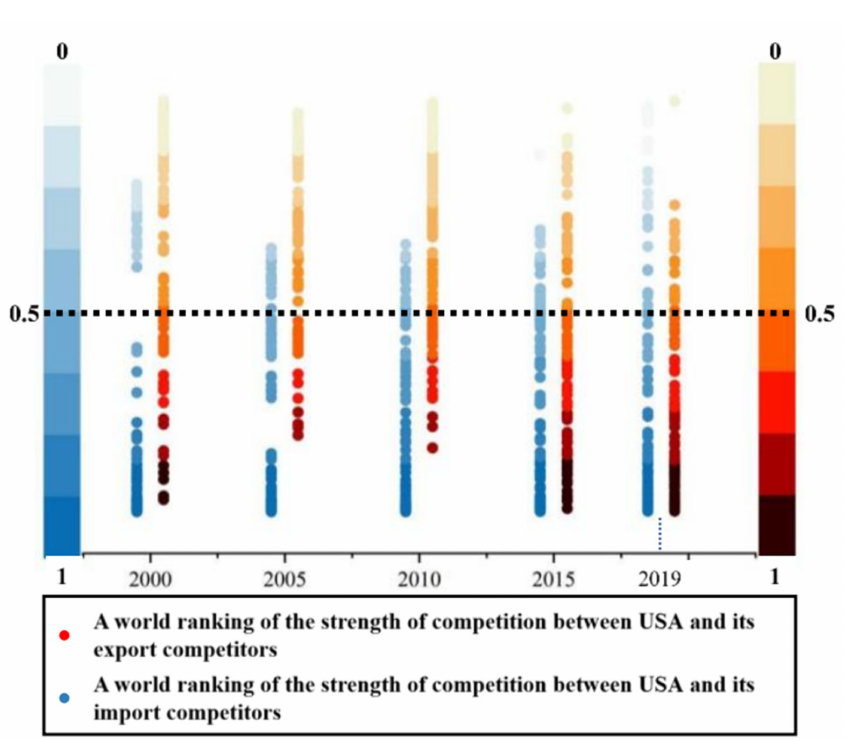
Figure 5. Changes in the competition intensity rankings of the US and other countries in